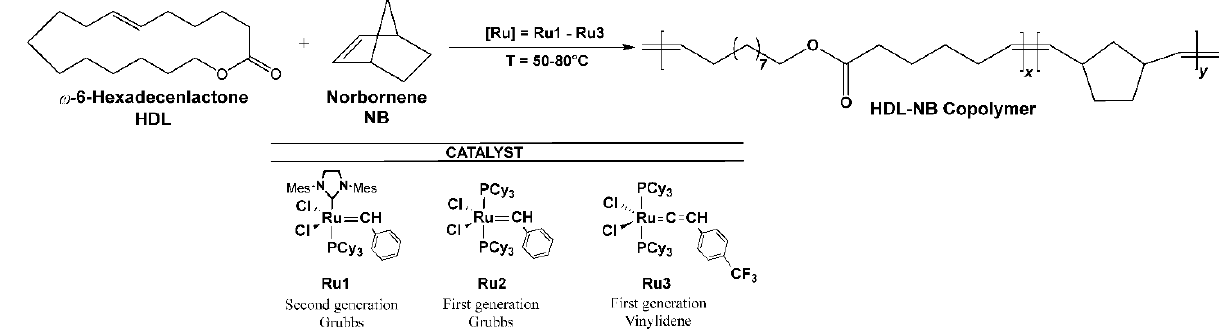
Table 1. Copolymerization via ROMP of w -6-hexadecenlactone (HDL) with norbornene (NB) using Ru1–3